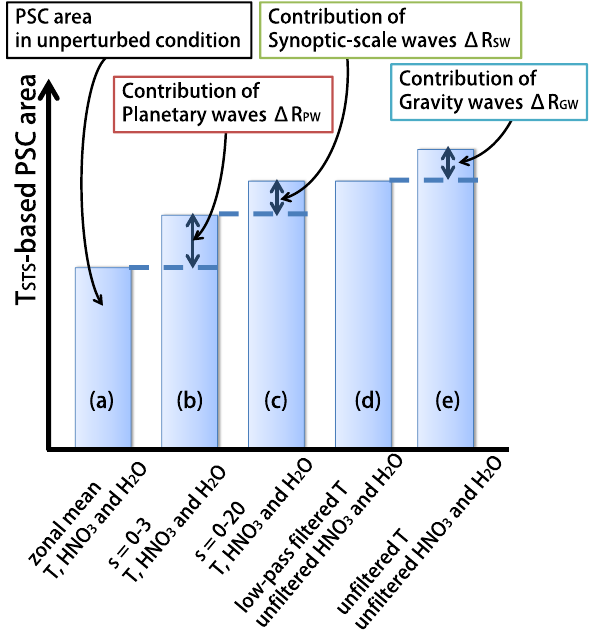
Fig. 9. A method to estimate the effects of planetary waves, synoptic-scale waves and gravity waves on PSC areal extent. (a) T STS -based PSC area calculated from s = 0 componets (i.e. zonal- mean) of temperature from ERA-Interim data and mixing ratios of HNO 3 and H 2 O from Aura MLS. (b–c) Same as (a) but for s = 0–3 and s = 0–20 components, respectively. (d–e) T STS -based PSC area calculated from smoothed and original temperature from COSMIC, respectively. The cutoff length of the lowpass filter used for tem- perature in (d) is 6km. The unfiltered mixing ratios of HNO 3 and H 2 O are